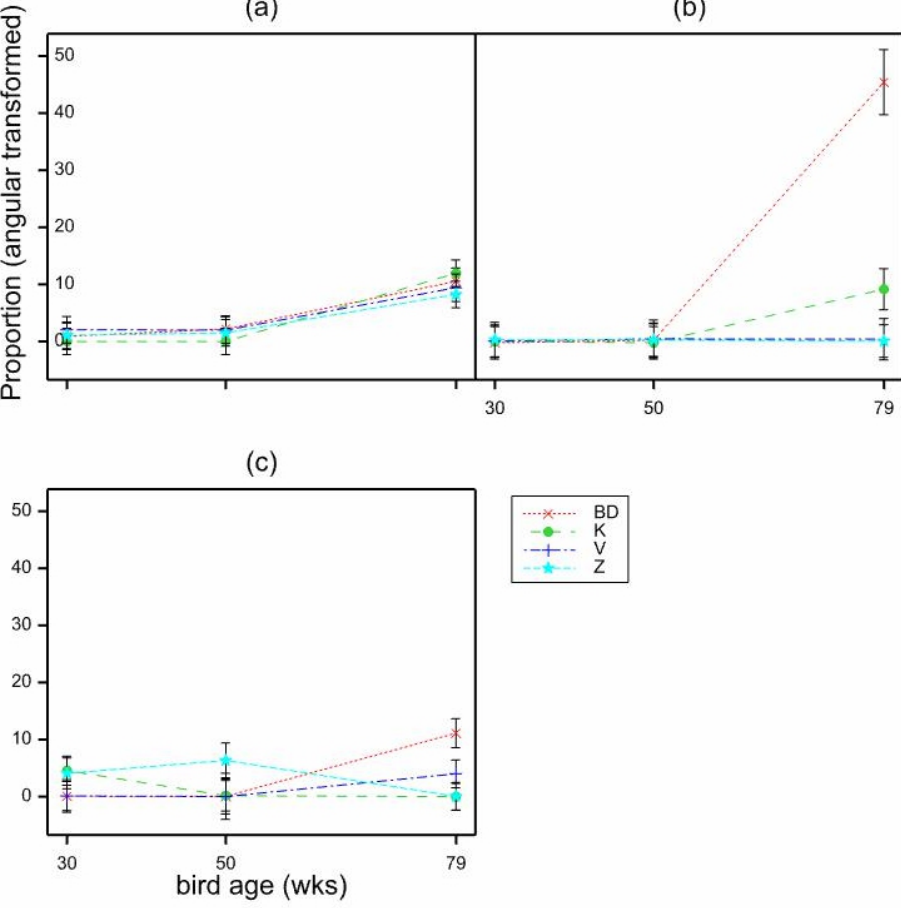
Figure 10. Mean proportions (angular transformed) of cracked eggs per location according to location (laid opposite the ( a ) nest, ( b ) scratch, ( c ) other cage areas), bird age (30, 50 and 79 weeks) and scratch mat type (BD, K, V, Z), estimated from LMM. Mean SE